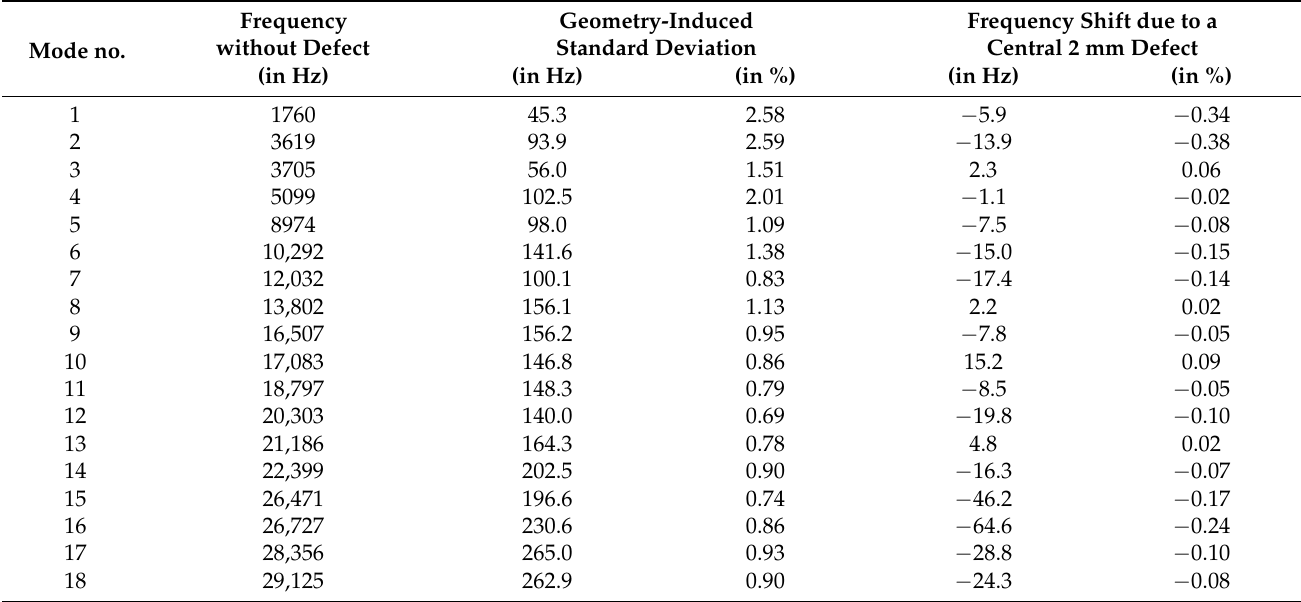
Table 1. Statistics to characterize the connecting rod eigenfrequencies with regard to the frequencies in undamaged case, the frequency variations caused by geometric part-to-part variations, and the impact of a through-hole with 2 mm in diameter being central within the bar area.